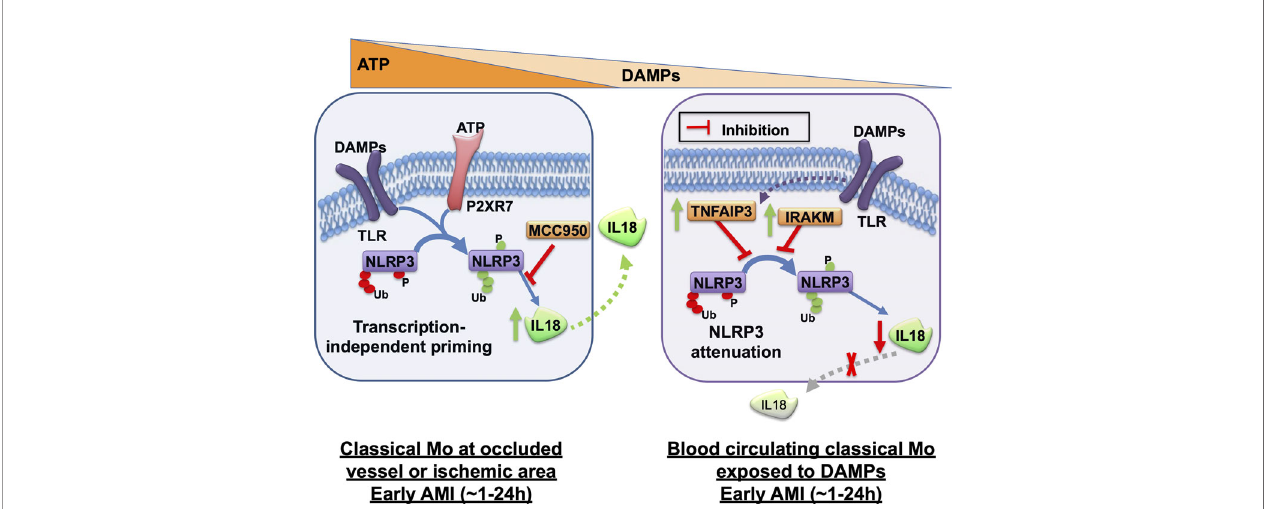
FIGURE 7 | Graphical summary of rapid in fl ammasome activation events in monocytes during acute myocardial infarction. Rapid in fl ammasome activation happens after simultaneous dual signal, DAMP-induced TLR priming and extracellular ATP sensing by P2RX7 at the injury site. TLR signaling triggers removal of ubiquitin modi fi cation or phosphorylation (red tags) of basal NLRP3 that repress in fl ammasome complex formation. The same signaling cascades also induces post- translational modi fi cations in other residues that enhances in fl ammasome activation (green tags). P2RX7 ion-channel activation triggers intracellular K+ ef fl ux, which induces NLRP3 multimerization. Active in fl ammasome complex recruits pro-CASP1, its catalytic activation and subsequent pro-IL18 cleavage and release. Rapid in fl ammasome activation and IL18 release happens in classical monocytes (Mo) at the site of the occluded vessel or in the ischemic area at the early phase of AMI, within the fi rst hours after infarction (left panel). This pathway releases very low levels of IL-1 b because IL-1 b is transcription dependent. NLRP3 speci fi c inhibitor, MCC950, can block this process. Circulating monocytes in the blood away from the site of ischemic lesion are potentially only able to sense DAMPs but not the short-lived ATP. Activation of only TLR signal induces upregulation of the anti-in fl ammatory mediators TNFAIP3 and IRAKM. TNFAIP3 potentially modulates a concomitant decline of in fl ammasome priming alongside a signi fi cant decrease of acute IL18 release in a protective mechanism against systemic in fl ammatory hyper- activation (right panel). The given time frames in this graphical summary are just an estimated guess of the